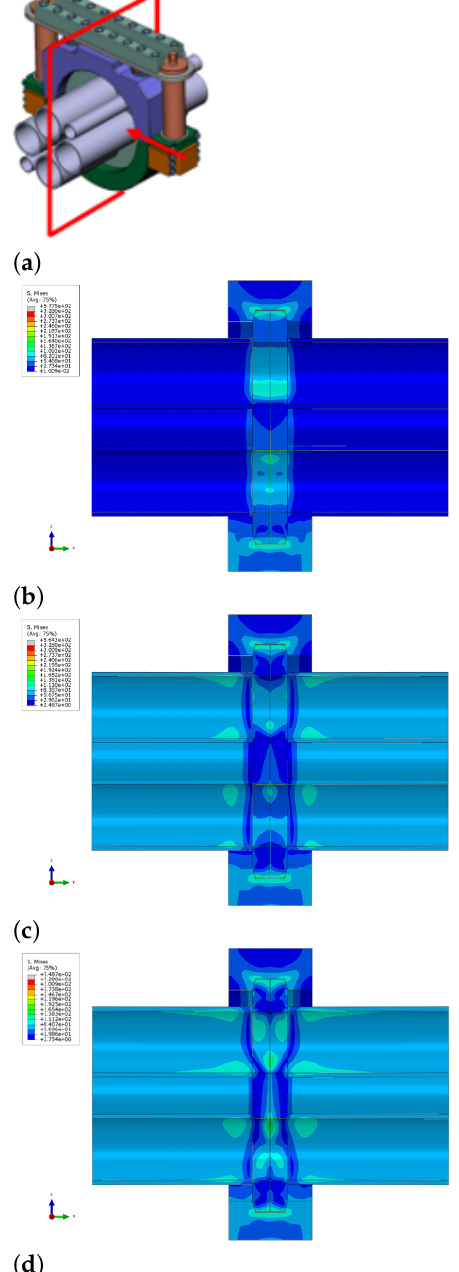
Figure 4. Preliminary finite-element analysis of the hub-and-clamp design. ( a ) Cross-section plane. ( b ) sealing load with 2700 kN applied. ( c ) Coolant pressure 9.6 MPa and 2700 kN sealing load applied. ( d ) All first pipe seals failed. Hydrostatic load surface increased due to